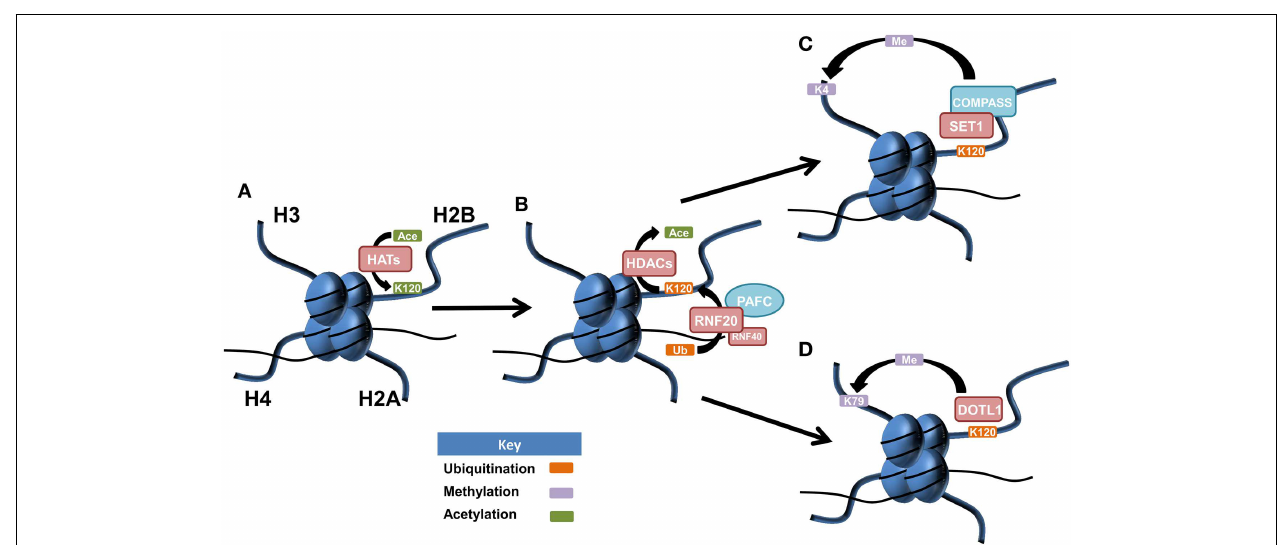
(PAFC) to facilitate monoubiquitination of lysine 120 (H2Bub1). (C) SET1 is recruited to the site of H2Bub1 where it interacts with COMPASS (complex of proteins associated with Set1) to facilitate the active mark of methylated histone 3 at lysine 4 (H3K4me). (D) H2Bub1 can recruit and activate the DOT1L methyltransferase, responsible for the active chromatin mark of methylated histone H3 at lysine 79